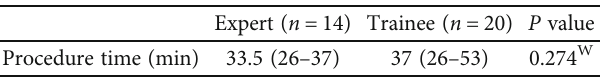
Table 2: Comparison of surgical times between trainees and experts in the ORB